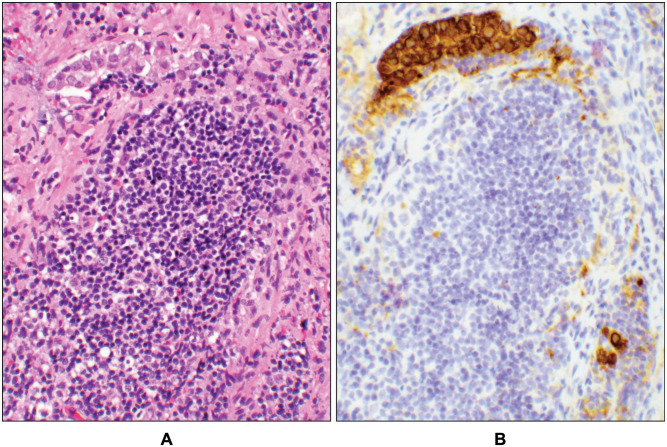
Micrometastasis.A sentinel lymph node with micrometastatic carcinoma (case # 58, S1 and S5 Tables). (A) A cluster of tumor cells seen by hematoxylin and eosin (H&E) stain. (B) Cytokeratin immunohistochemical stain highlighted the same focus of the tumor seen on the H&E slide (10x objective).